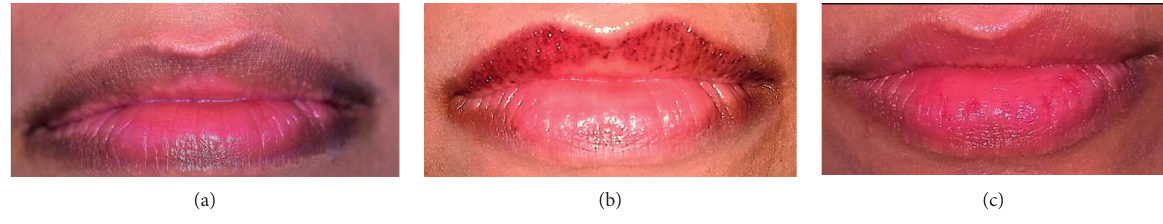
Figure 11: (a) Before, (b) mild crust, and (c) after